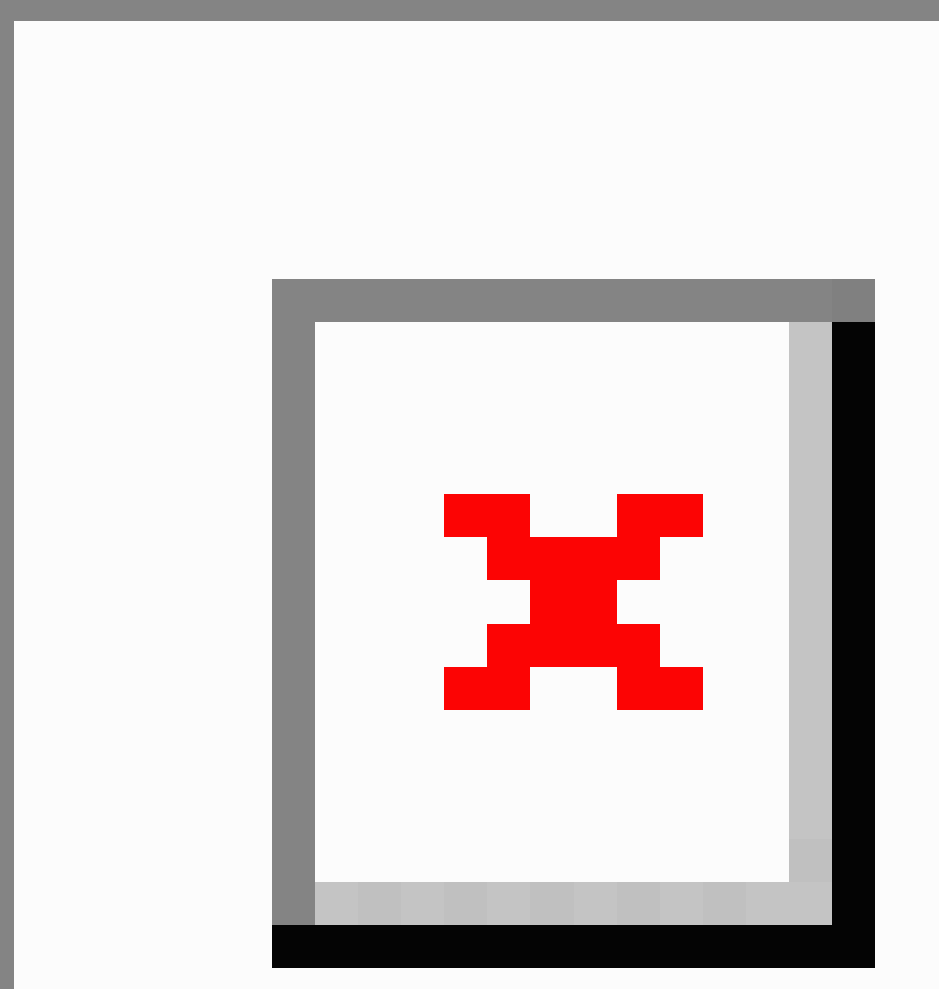
Figure 3. Proportion of discordant responses by self-reported attribute and panel